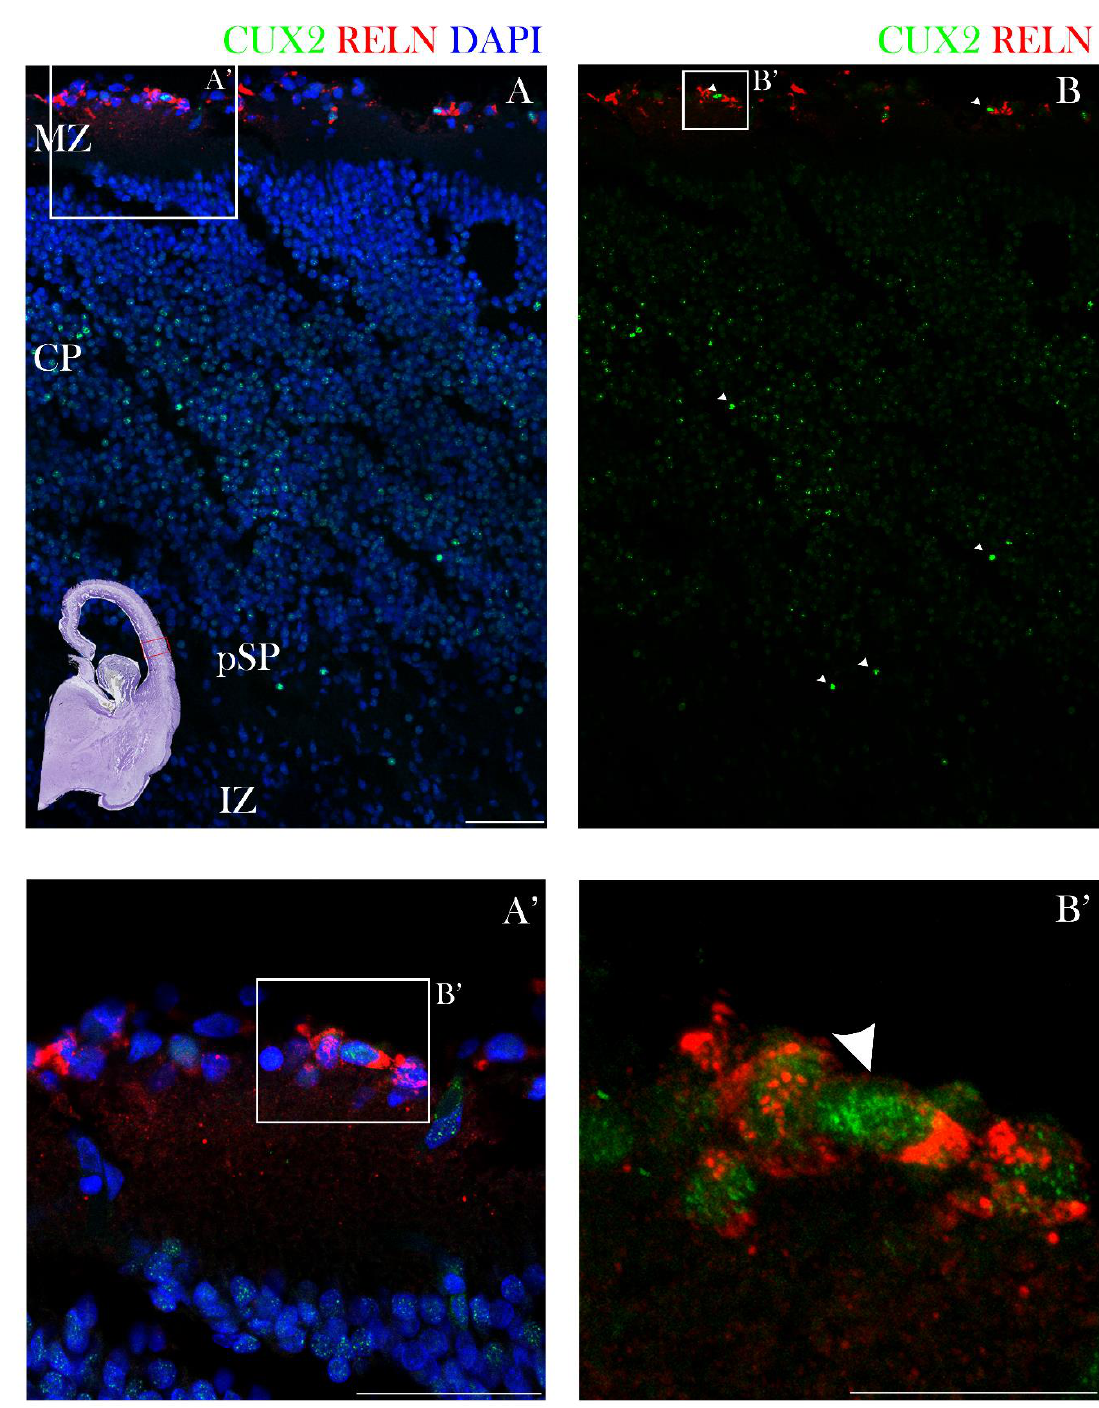
Figure 2. CUX2 co-localizes with Cajal-Retzius neuron subtype marker Reelin in the MZ during the pSP phase at 12 PCW. ( A,B ) Midlateral portion of a prospective precentral region of the developing cerebral wall (indicated by box in the Nissl stained complete scan of the coronal section in the lower left corner) during the pSP phase was immunostained for CUX2 (green), Reelin (red), and DAPI (blue). ( A ) A representative confocal image shows evenly spaced CUX2+ nuclei were located in the MZ, while CUX2 was not detected in proliferative VZ and SVZ. ( B ) Reelin co-localized with CUX2+ nuclei in the upper third of the MZ (magnified in A’ and B’ ). Scale bar = 50 µm.